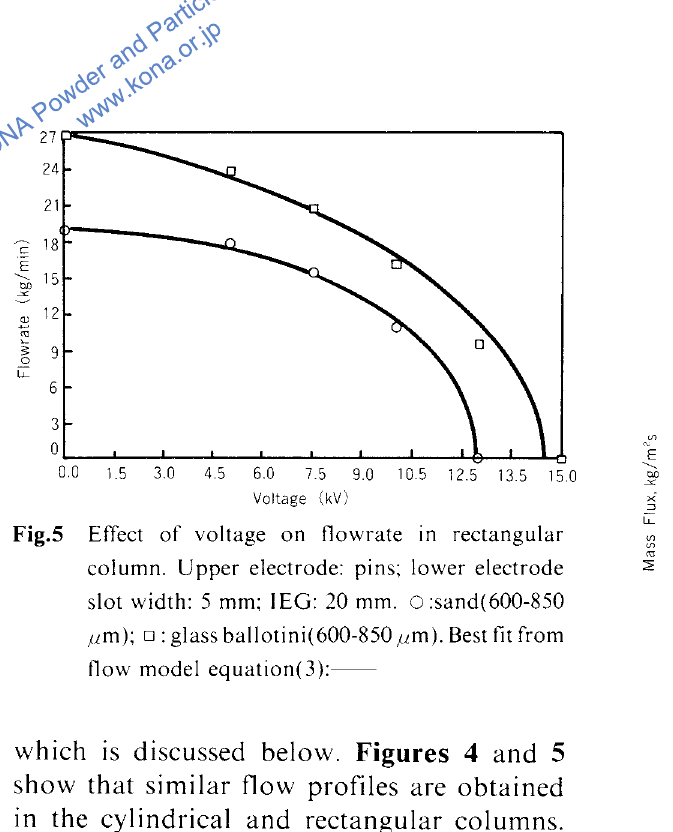
Fig.S Effect of voltage on flowrate in rectangular column. Upper electrode: pins; lower electrode slot width: 5 mm; lEG: 20 mm. o :sand(600-850 11 m); o: glass ballotini(600-850 1 ,m). Best fit from flow model equation(3):--